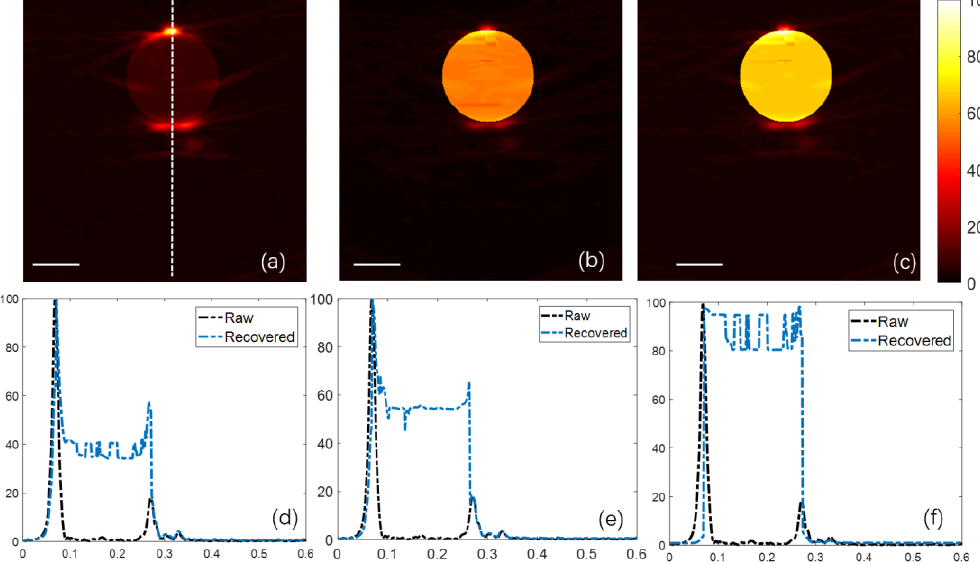
Figure 8. ( a – c ) show the absorption distribution recovery of the 3rd, 6th and 13th iteration respectively, all the scale bars (short solid white line) are 1 m; The white dotted line in ( a ) represents the selected A-line ( d ) ( e , f ) show the A-line profiles of iteration results respectively corresponding to the absorption distribution ( a – c ). The black dotted line represents the raw B-scan PA signal, the dotted blue line represents the recovery of the absorption coefficient. The x-coordinate axis (bottom) in ( d – f ) illustrate the spatial scale, the unit is cm, the ordinate (left) represents the value of the absorption coefficient, the unit is cm − 1 .